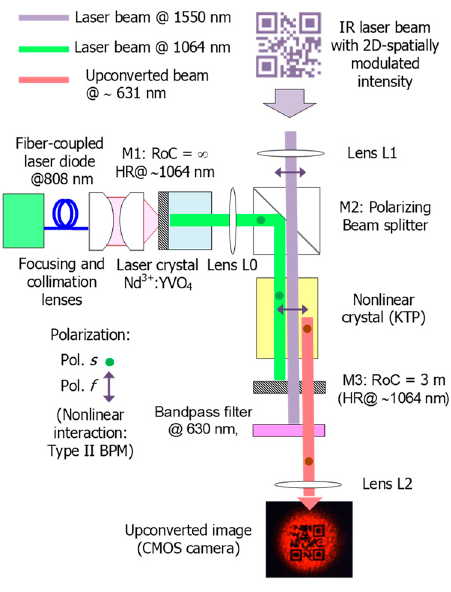
Figure 4. Experimental setup of the image up ‐ conversion system proposed for sensing.